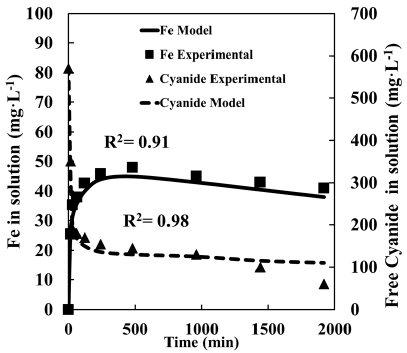
Figure 2. Iron and free cyanide concentrations in solution for the pyrite leaching system.